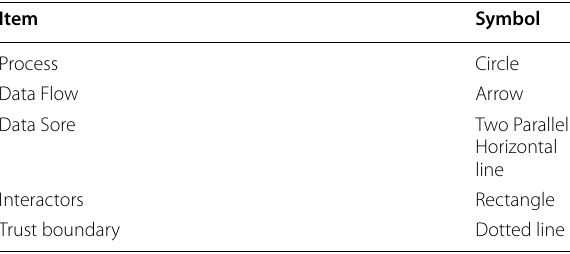
Table 12 Components of